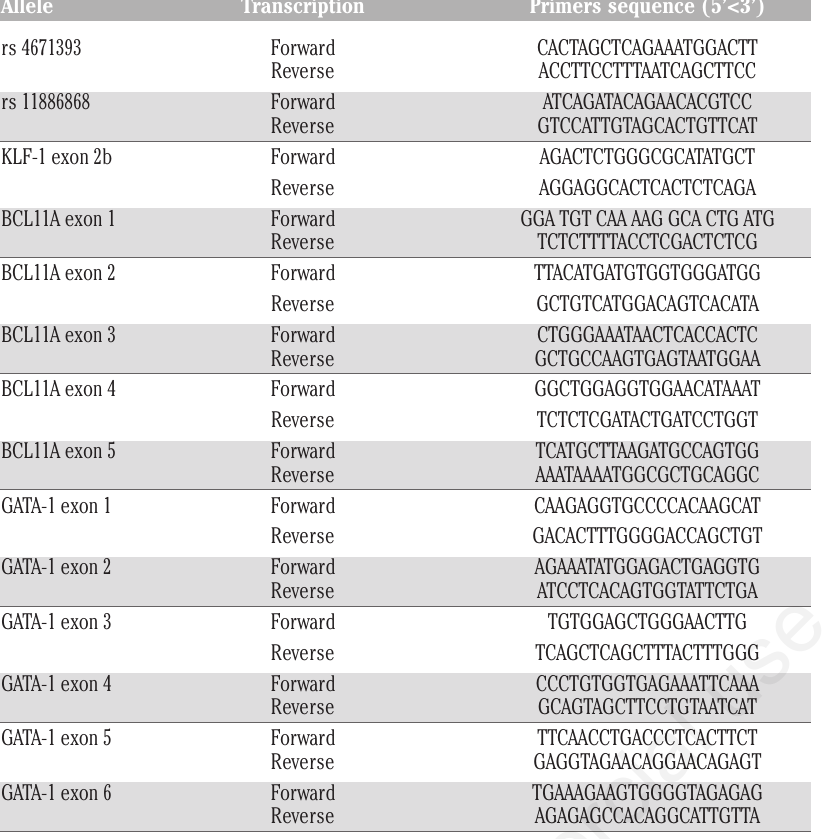
Table 2. Primer used for amplification and detection of the single nucleotide polymor- phisms and alleles.